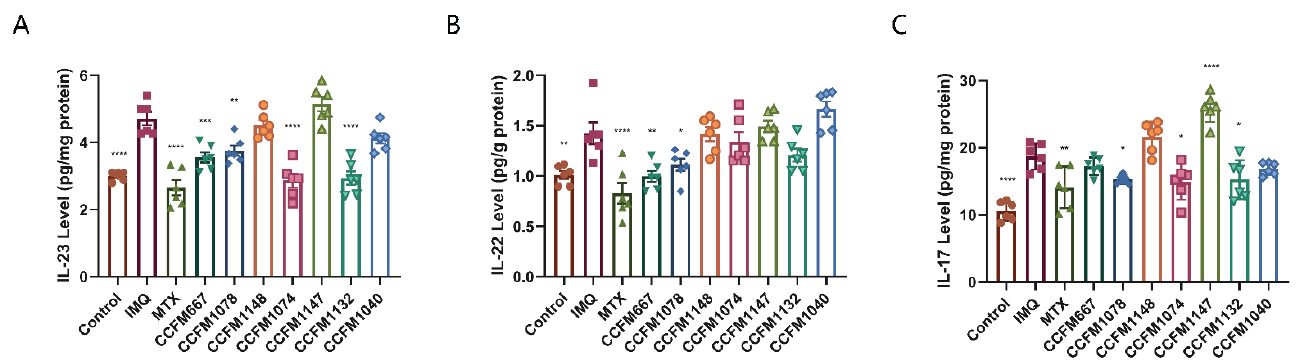
Figure 4. Effects of probiotics on levels of IL-23/Th17 axis-associated inflammatory cytokines. ( A ) IL-23 levels ( n = 6). ( B ) IL-22 levels ( n = 6). ( C ) IL-17 levels ( n = 6). * p < 0.05, ** p < 0.01, *** p < 0.001 and **** p < 0.0001.